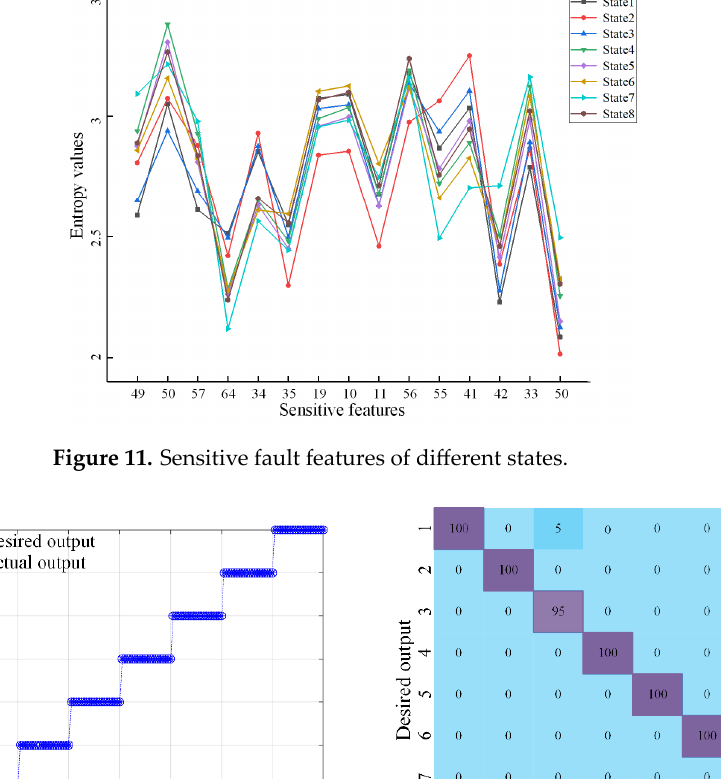
Figure 11. Sensitive fault features of different states.